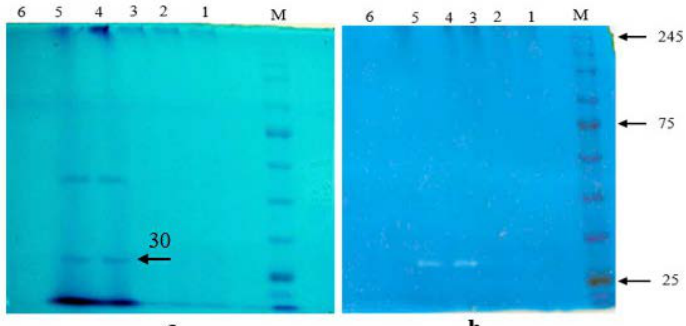
Fig. 2. Visualization of SDS-PAGE (a) and zymography (b) of keratinase from A. chrocoocum strain B4. Five samples of keratinase purification protocol were analysed: lane 1= ammonium sulfate (70%), lane 2= dialysis, lane 3= fraction (23 th ), lane 4= fraction (24 th ), lane 5= fraction (25 th ), lane 6= fraction (35 th ). M = Protein Marker, Color Prestained Protein Standard (BioLabs Inc, New